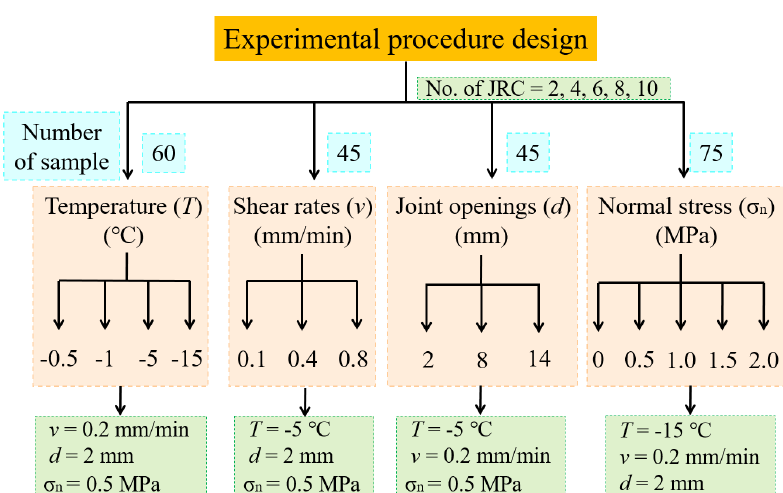
Figure 3. Distribution of rock samples containing ice-filled joints. T : temperature. v : shear rates. d : joint openings. σ n : normal stress.